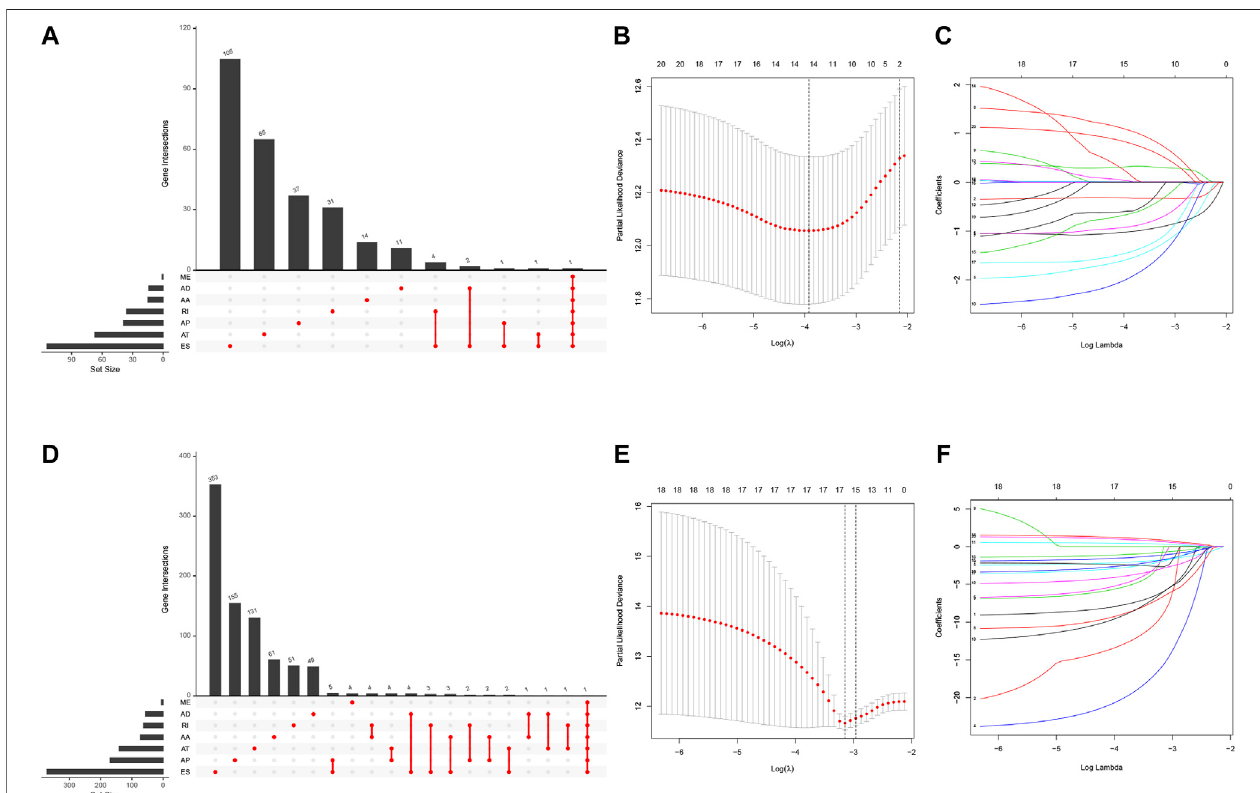
FIGURE 5 | Identi fi cation of NSCLC prognosis-related AS events. (A) The prognostic upset plot. The data exhibit the m6A-related prognostic AS events in LUAD. (B, C) The LASSO Cox analysis. These 13 m6A-related AS events associated with LUAD prognostics and the optimal values of the penalty parameter were assessed using the 10-round cross-validation. (D) The prognostic upset plot. The data exhibit the m6A-related prognostic AS events in LUSC. (E, F) The LASSO Cox analysis. These 15 m6A-related AS events associated with LUSC prognostics and the optimal values of the penalty parameter were determined by the 10-round cross- validation. LUAD, lung adenocarcinoma; LUSC, lung squamous cell carcinoma; m6A, N6-methyladenosine; OS, overall survival: AS, alternative